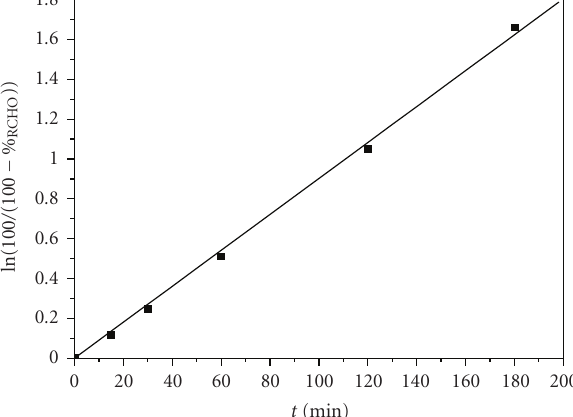
Figure 6: Kinetic plot relative to the photo-oxidation in the presence of S200